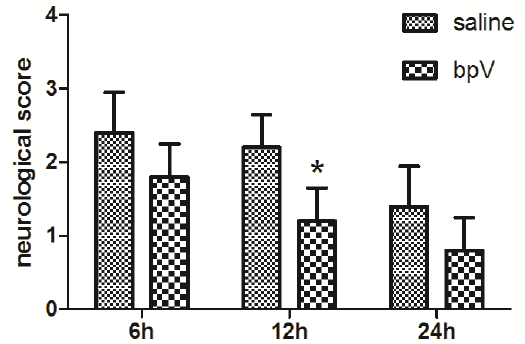
Figure 2. Neurological deficits scores of both bisperoxovanadium (bpV)- and saline-treated animals 6, 12 and 24 h after reperfusion. Neurological deficits were significantly ameliorated in rats treated with bpV compared with saline-treated controls at 12 h after reperfusion, but not at 6 or 24 h after reperfusion. n = 5, * p =